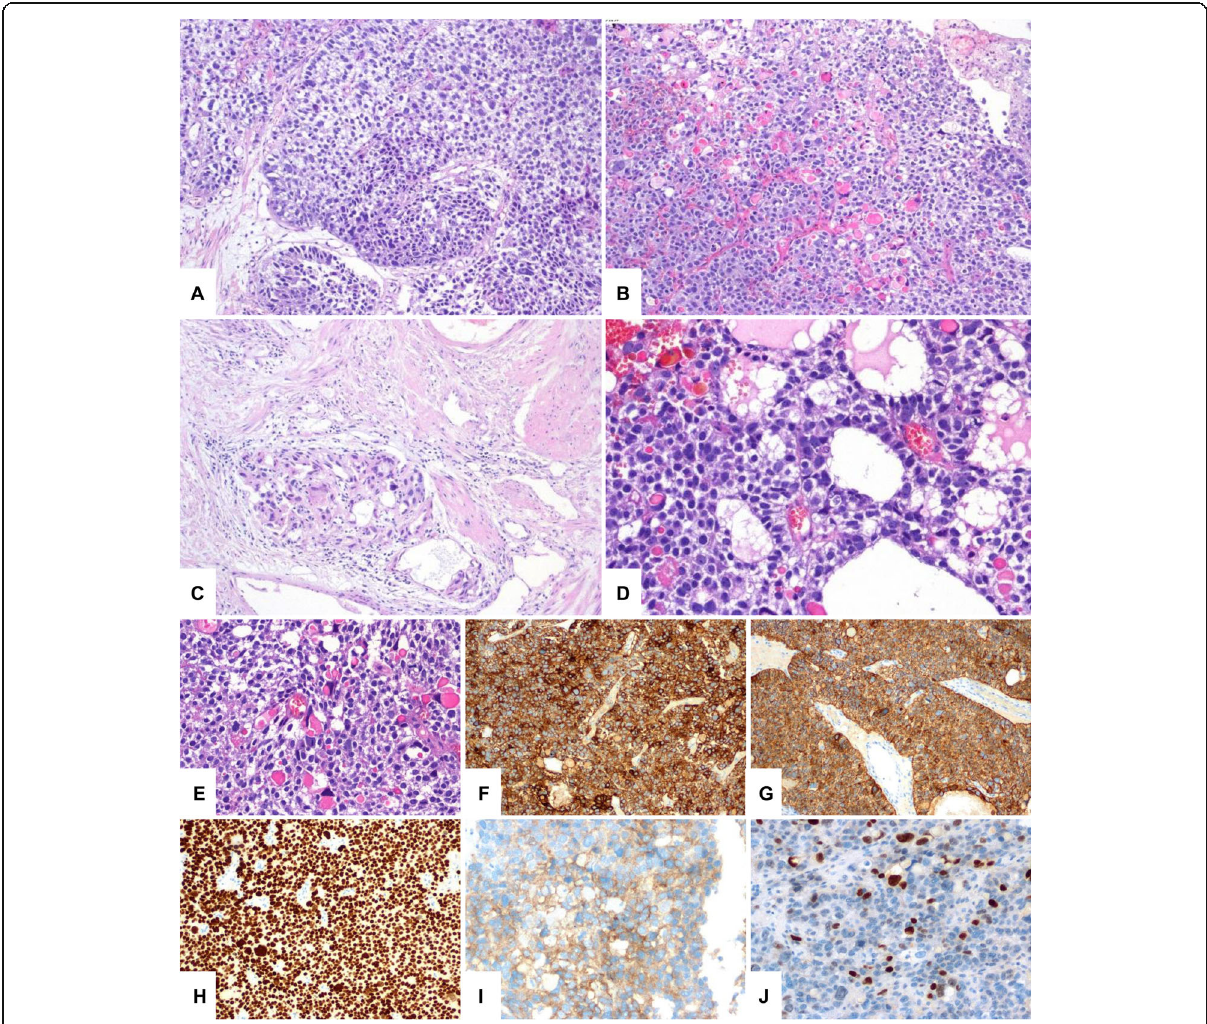
Fig. 2 A Superficial areas of the resected tumor showed urothelial carcinoma with papillary morphology. B Different parts of similar tumors are shown, including solid and adenoid areas with clear cells and hyaline globules (stars). C Carcinoma nests were found among smooth muscle fascicles of the bladder wall. D There were glandular formations within the tumor. E There were clear cells and hyaline globules.